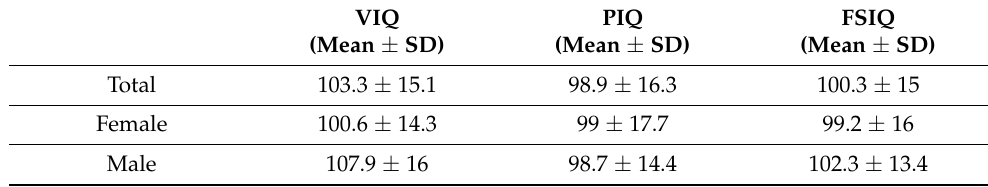
Table 4. WPPSI-III scores.